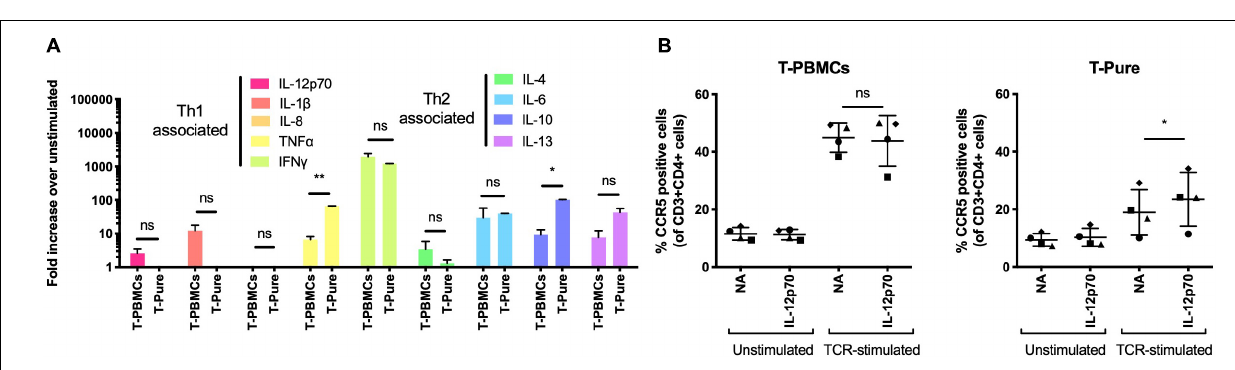
FIGURE 3 | Interleukin-12 enhances CCR5 expression on CD4+ T cells from T-Pure cultures. (A) T-PBMCs and T-Pure cells were TCR-stimulated or left unstimulated for 72 h. Cell culture supernatants were then harvested and analyzed for expression of 9 cytokines by the MSD V-Plex proinflammatory panel 1 kit. Cytokine expression within TCR-stimulated cells is represented as fold-increase over unstimulated cells and grouped based on T helper 1 (Th1)- and T helper 2 (Th2)-associated cytokines. ( n = 2 donors). Paired students t -test, * P < 0.05, ** P < 0.01, ns, not significant. (B) T-PBMCs (left) and T-Pure cells (right) were left unstimulated or TCR-stimulated for 48 h. Cells were then washed to remove antibodies, cultured with or without 0.25 ng/ml recombinant human IL-12p70 for an additional 48 h and the frequency of CCR5+ CD4+ T cells was analyzed by flow cytometry. Lines indicate mean and symbols represent individual donors ( n = 4). Paired students t -test, * P < 0.05, ns, not significant; NA, no